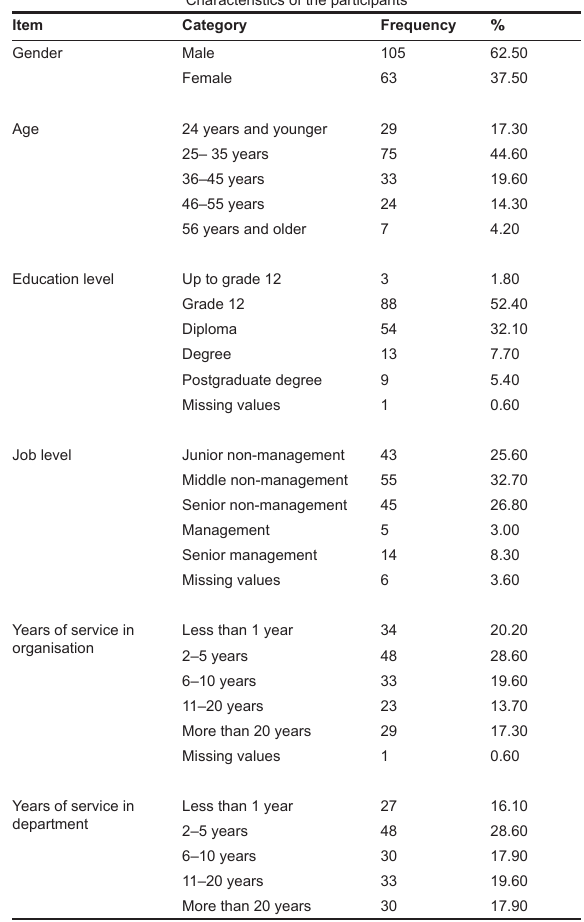
TABLE 1 Characteristics of the